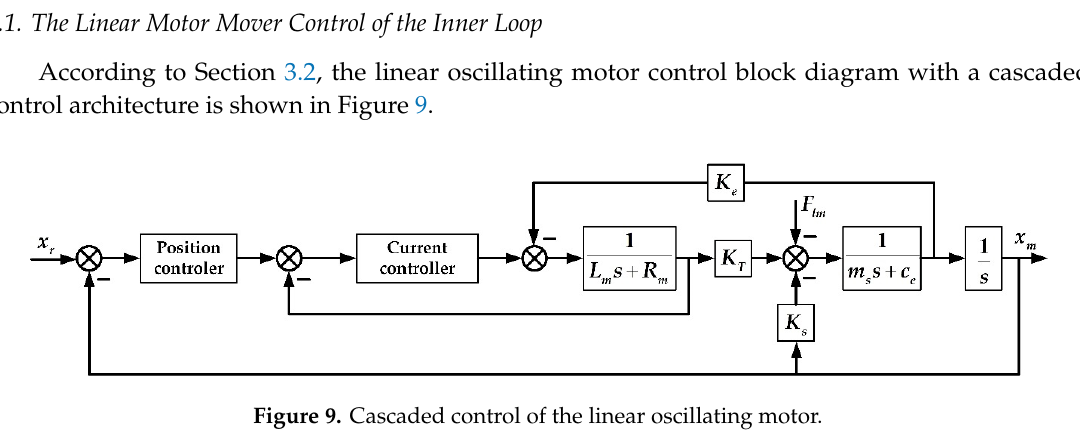
Figure 8. The inner loop and outer loop of the actuator control.